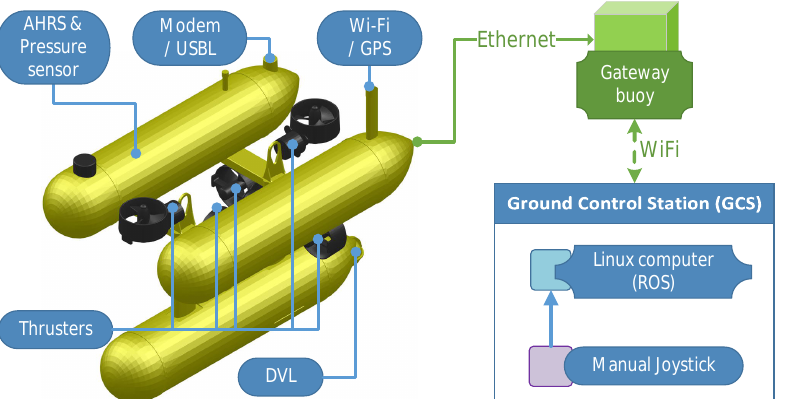
Figure 10. System overview for the Girona500 AUV with high- (ROS computer), and low-level (sensors and actuators)